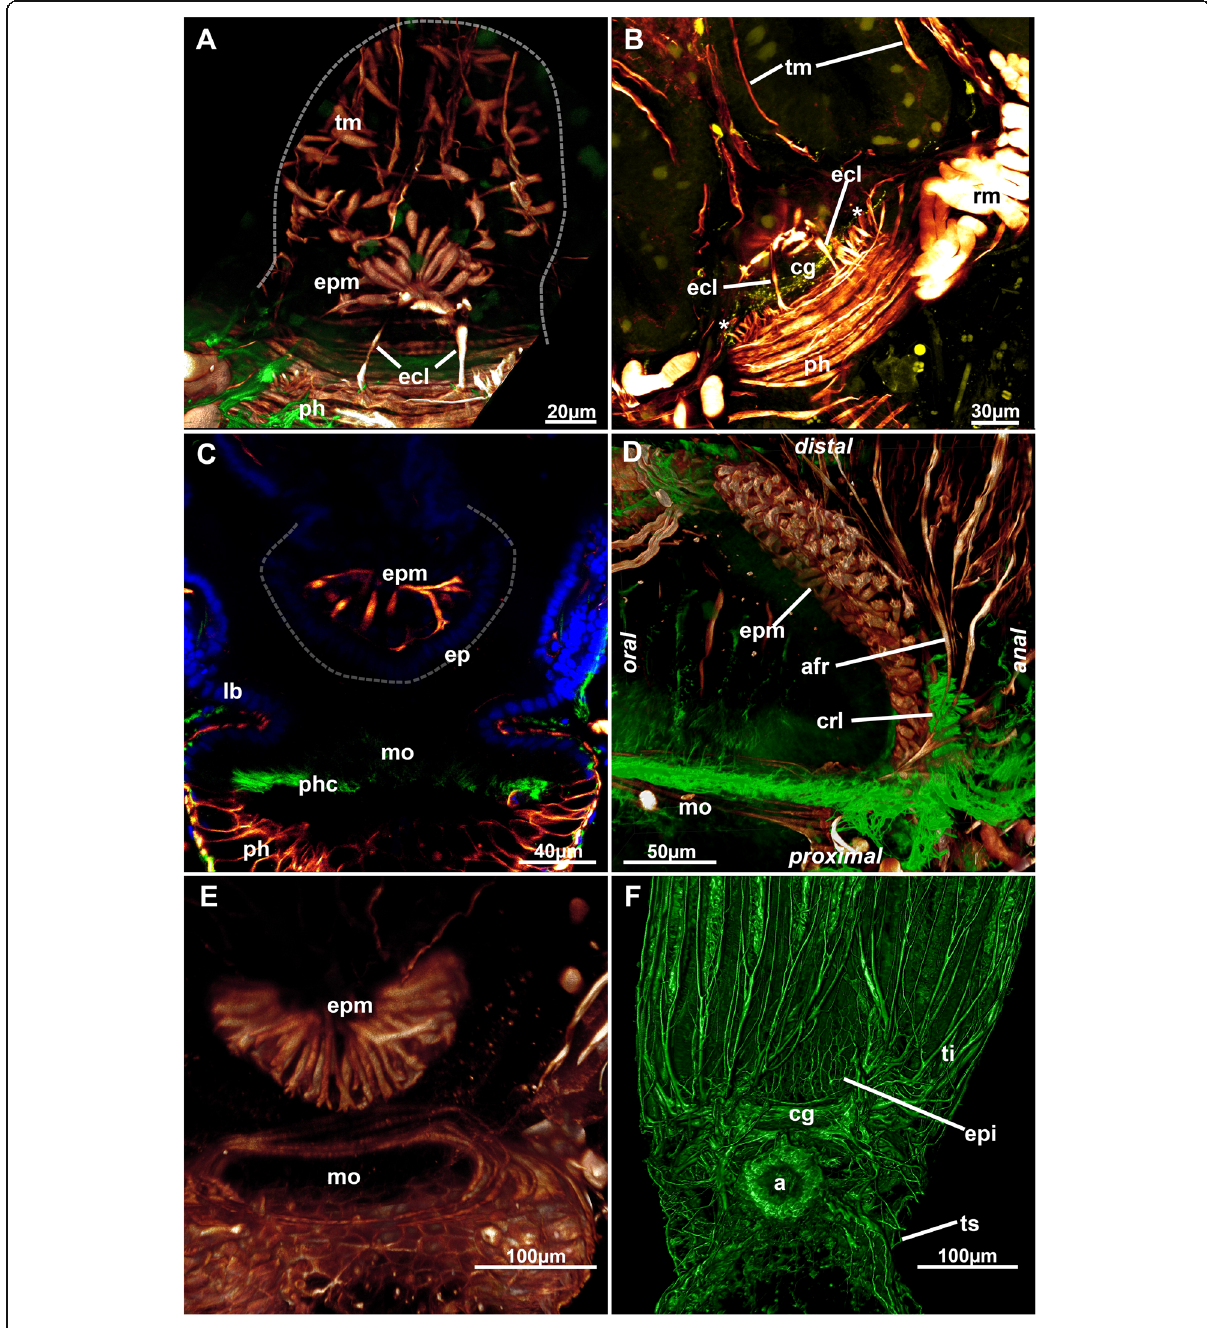
Fig. 6 Epistome myoanatomy and innervation of Stephanella hina . Confocal laser scanning microscopy stacks based on acetylated alpha-tubulin labelling. Volume renderings, projections or optical slices. Acetylated alpha-tubulin in green LUT, f-actin in glow LUT. a Volume rendering of the epistomial musculature from the anal side. Note the lateral epistomial canal muscles. b Maximum projection of the same volume in A showing thin lateral muscle fibres lateral to the epistomial canal muscles. c Optical section through the foregut and the epistome showing individual, smooth muscle fibres crossing. d Lateral rendering showing epistomial musculature and dense lateral ciliation on their proximo-lateral side. e Volume rendering of the epistomial musculature. f Innervation of the epistome. A thin plexus extends directly from the cerebral ganglion. Abbreviations: a – anus, afr – abfrontal muscle root, cg – cerebral ganglion, crl – ciliary ridge laterally of the epistome, ecl – epistome